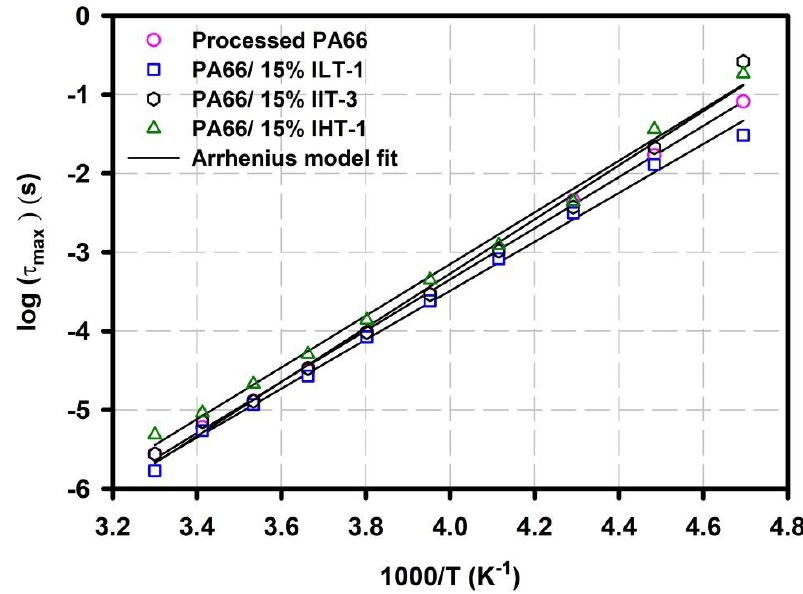
Figure 6. Arrhenius plots of the γ relaxation for the studied PA66 / P-glass systems and processed virgin PA66. Solid lines represent the Arrhenius equation fits.